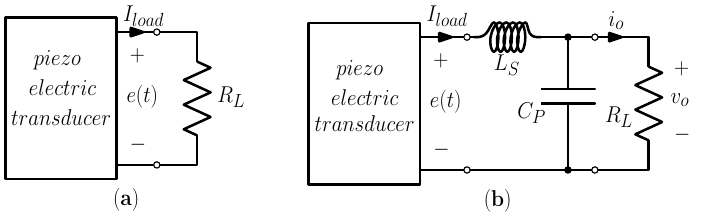
Figure 2. ( a ) Resistive load. ( b ) Matched load composed of a resistor and of a low-pass L-matching